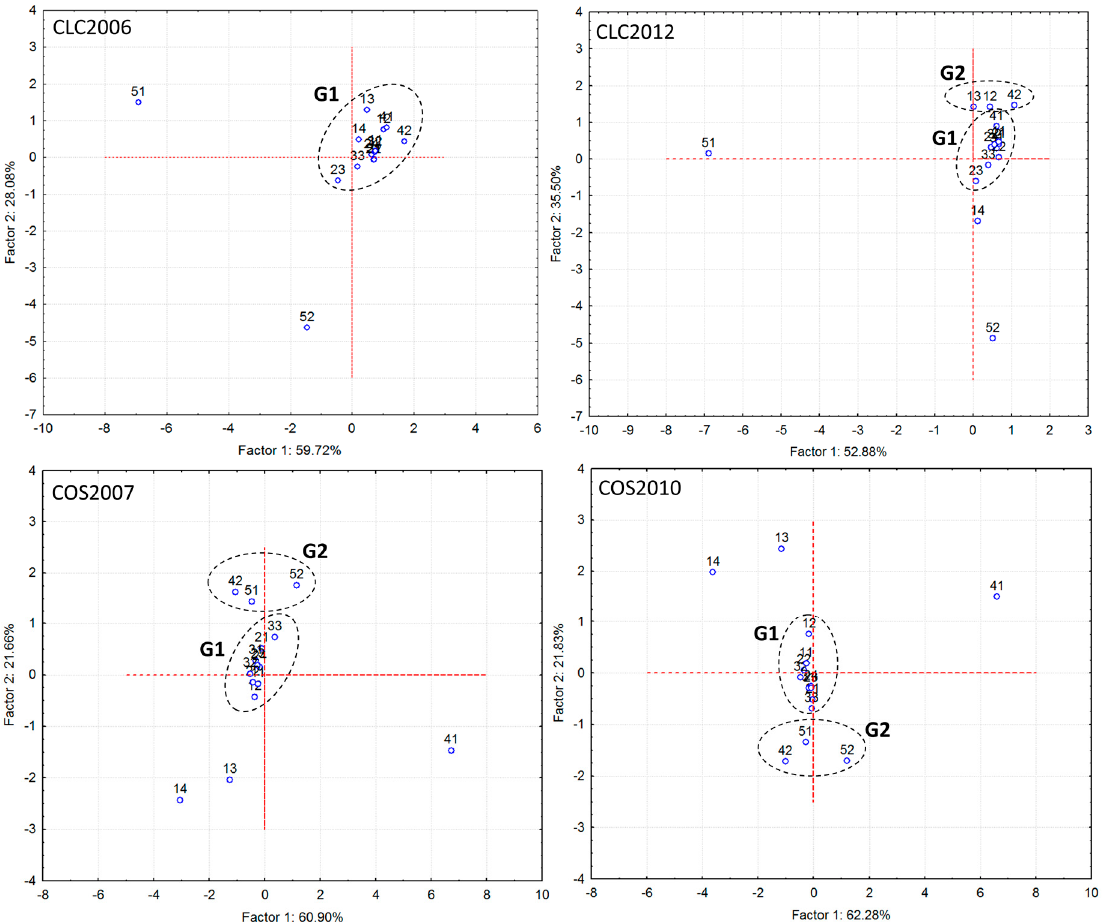
Figure 6. LUC class projection on the factor plane (LUC classes with sum of cosine squared ≥ 0). LUC codes: See legend in Figure 1.